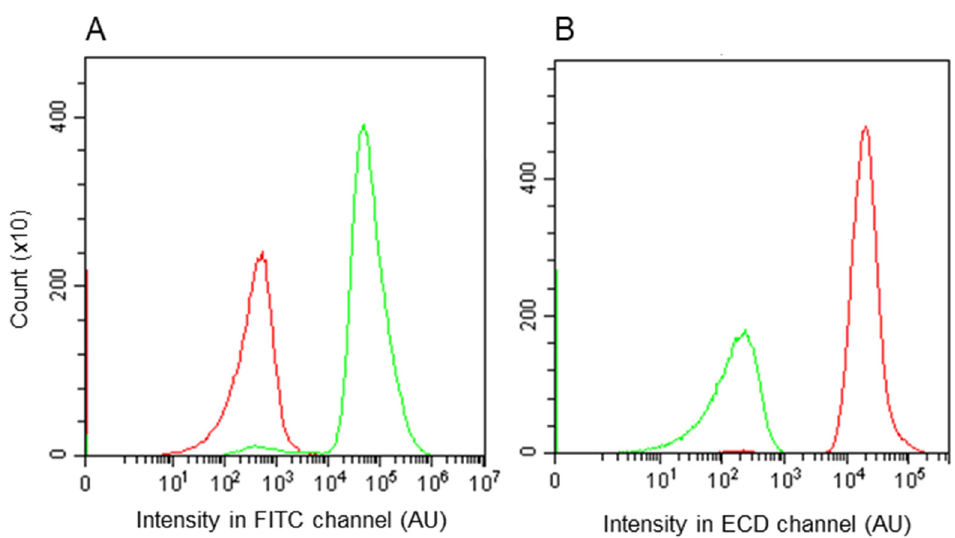
Figure 4. Histograms of individual KV10 (red line) and KV11 (green line) events counted for FITC ( A ) and ECD ( B ) channels. The Y -axis corresponds to the number of events. The X -axis corresponds to the intensity of fluorescence. The experiments were repeated three times with similar results, and one set of representative plots is shown.